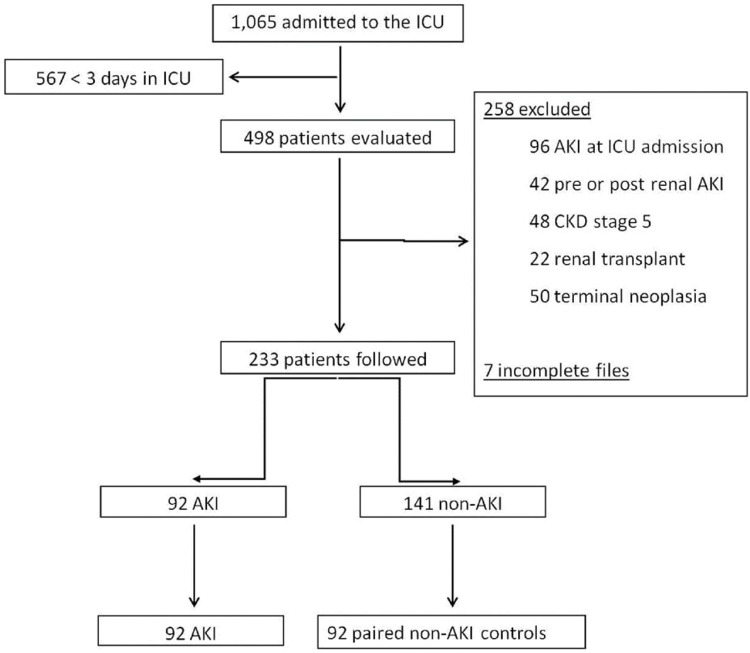
Study flowchart.